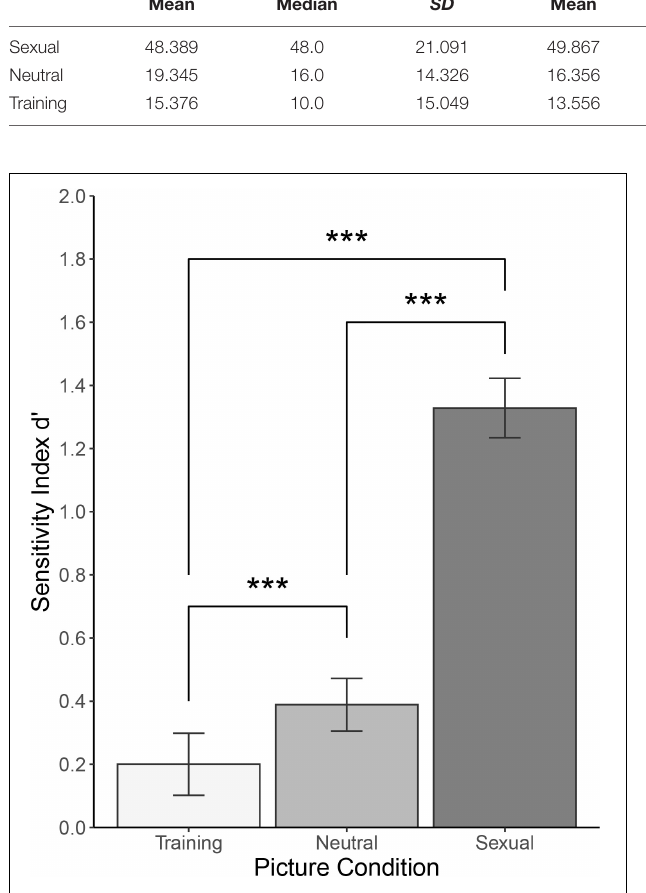
FIGURE 4 | Picture recognition task: Sensitivity index d’ for training, neutral, and sexual pictures. *** p < 0.001.